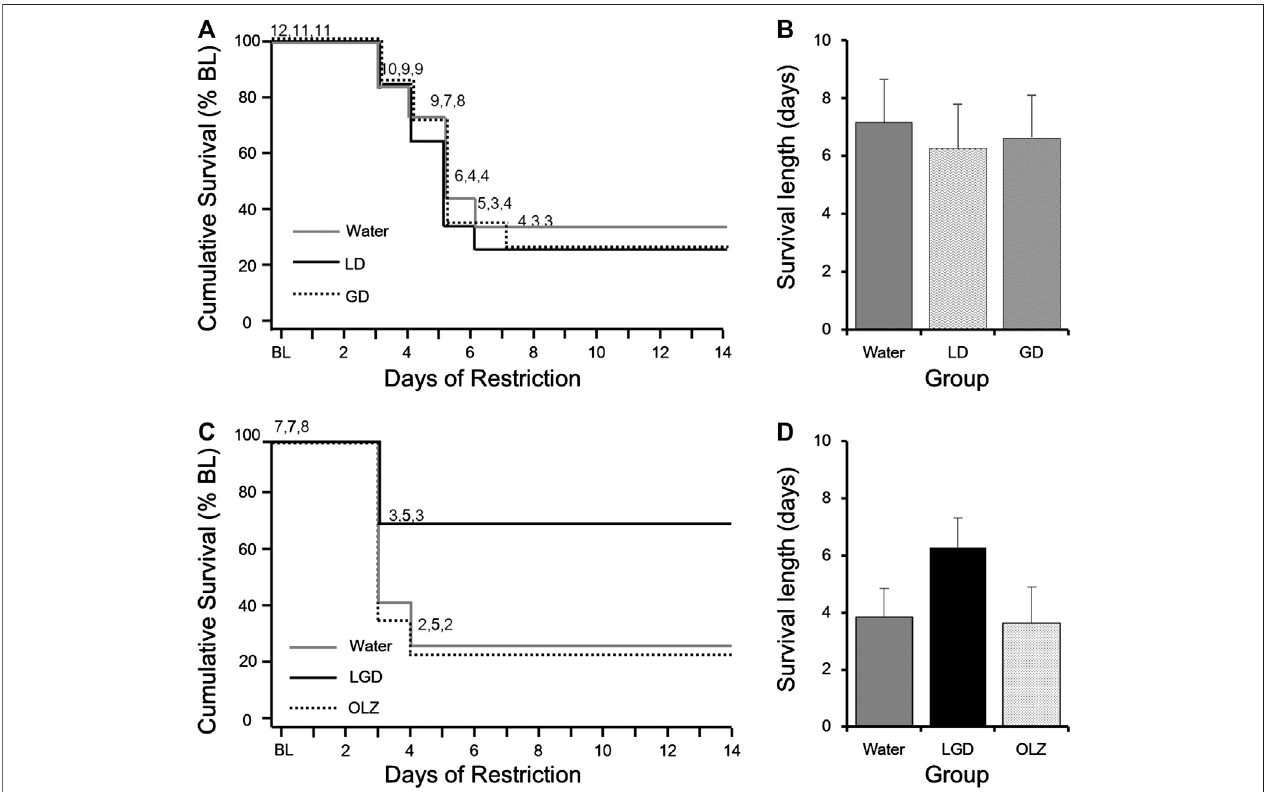
FIGURE 4 | The necessity of combination of licorice and dried ginger for survival in activity-based anorexia (ABA) mice (A) Comparison of survival curves of water, LD, and GD groups (B) Comparison ofsurvivallengths ofwater, LD, and GD groups (C) Comparison of survival curves ofwater, LGD, and OLZgroups (D) Comparison of survival lengths of water, LGD, and OLZ groups. All resultsare expressed as mean ±